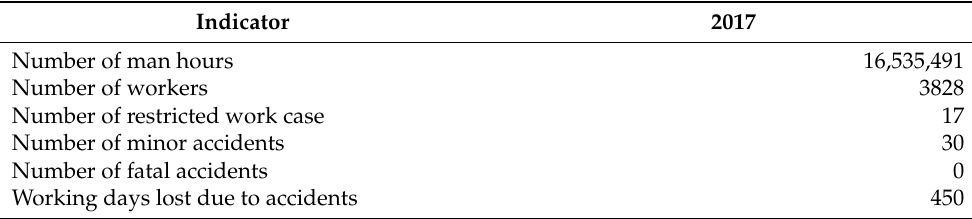
Table 10. Accident rate of a Peruvian construction company